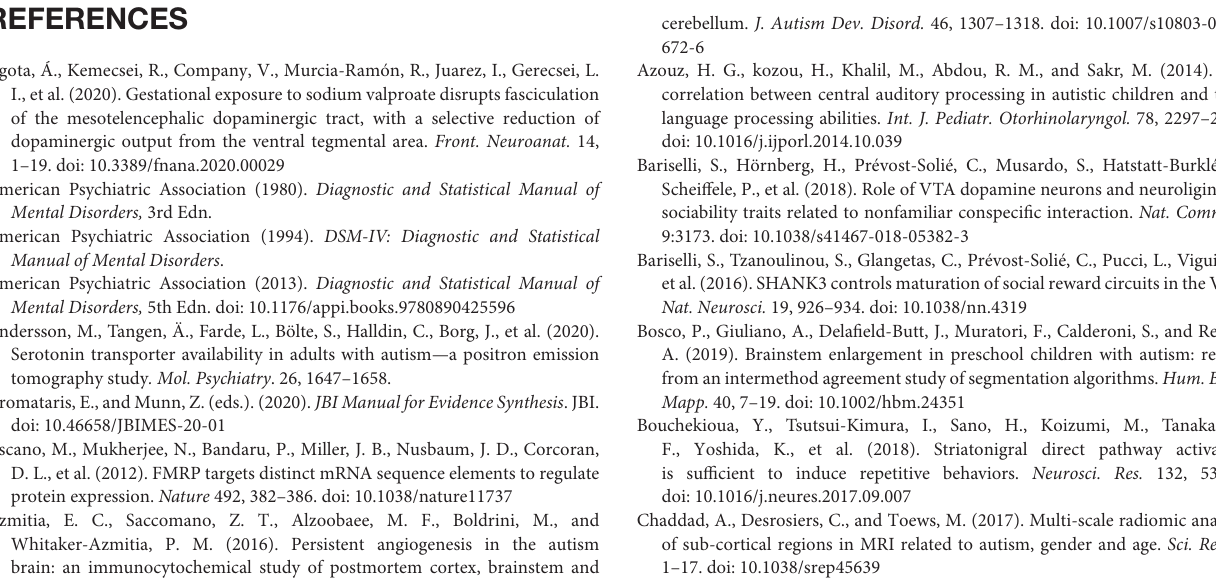
Supplementary Table 1 | Summary of all human studies. Supplementary Table 2 | Summary of all animal